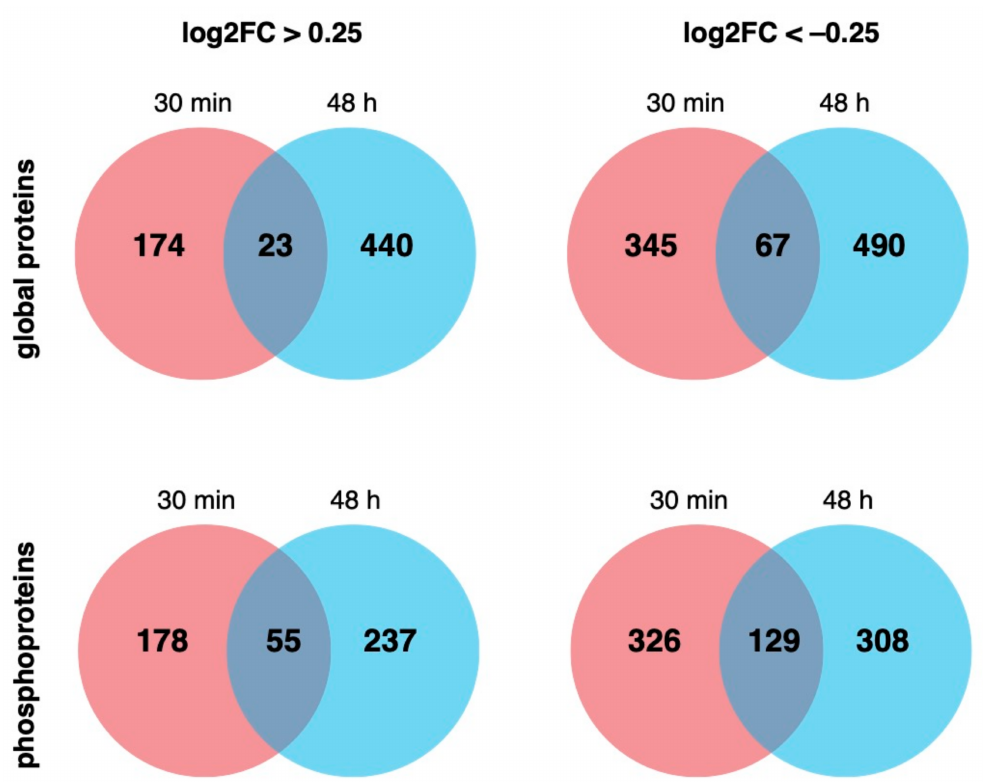
Figure 2. The number of proteins and phosphoproteins significantly upregulated or downregulated after 30 min (red) and 48 h (blue) and those similarly changed in both datasets are shown in the overlapping space.